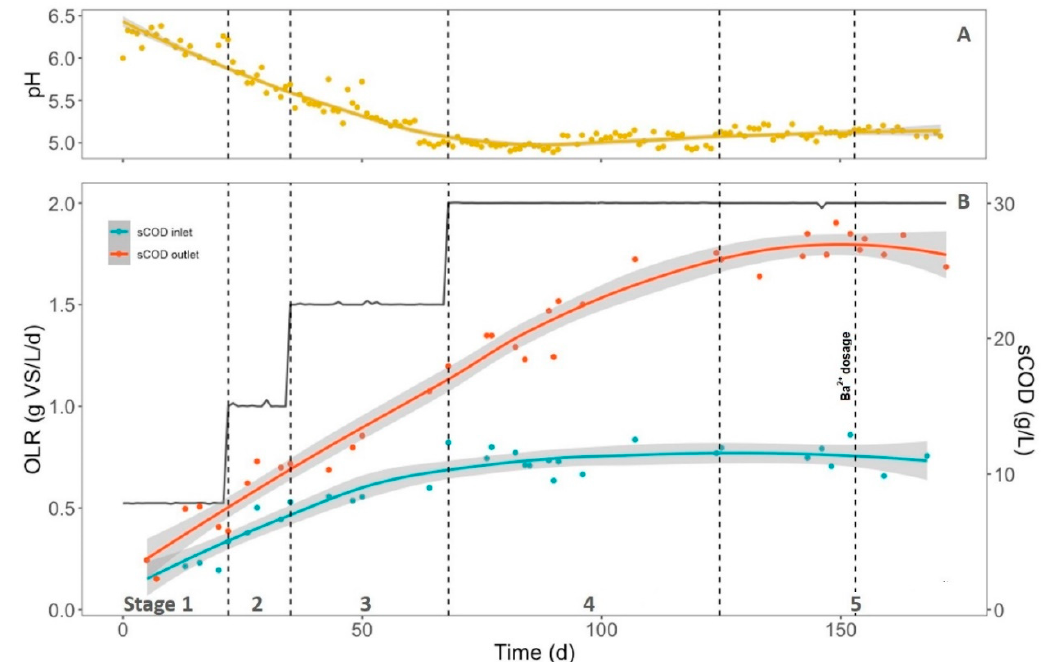
Figure 2. Organic loading rate (OLR) along the operation of the anaerobic semi-continuous hydrolytic reactor (ASHR) and monitoring results. ( A —pH results, B —OLR and soluble chemical oxygen demand (sCOD) results. The grey areas represent the confidence interval of the non-linear regression line). Table 6. Summary of monitoring results along ASHR operation .